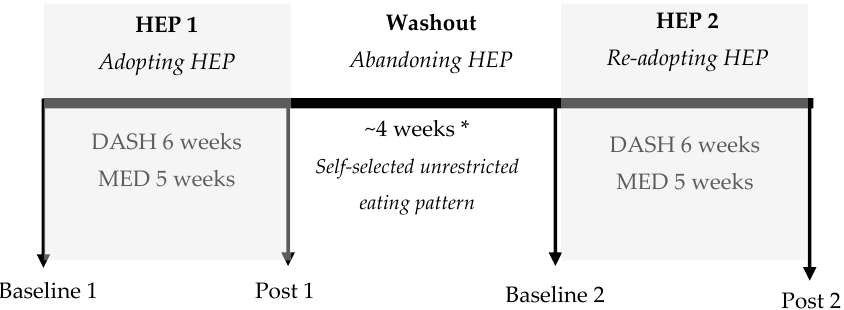
Figure 1. Study schematic of assessing effects of healthy eating pattern cycling on cardiovascular disease risk factors. Cardiovascular disease risk factors were measured at baseline 1, post 1, baseline 2, and post 2. Participants consumed self-selected foods during baseline 1, throughout the washout period, and during baseline 2. Participants consumed prescribed healthy eating patterns during post 1 and post 2. HEP, healthy eating pattern; DASH, Dietary Approaches to Stop Hypertension-style eating pattern; MED, Mediterranean-style eating pattern; * median = 28